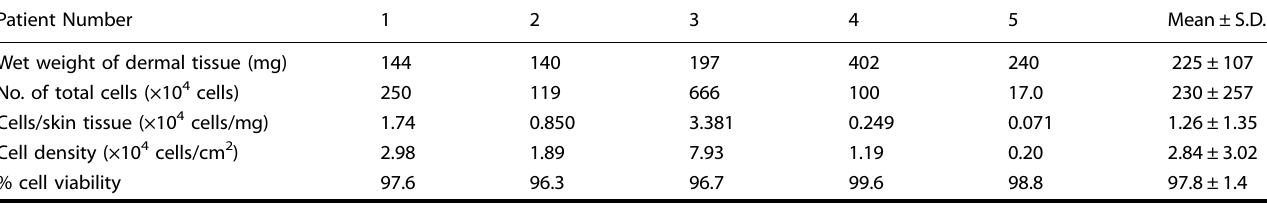
Table 2. The results of explant culture.